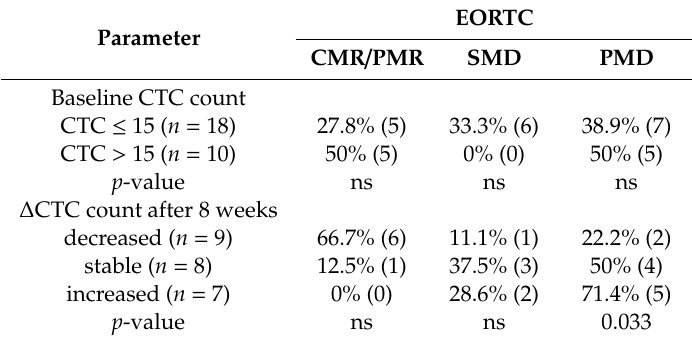
Table 1. Association between circulating tumor cells (CTC) count and response to immune checkpoint inhibitors